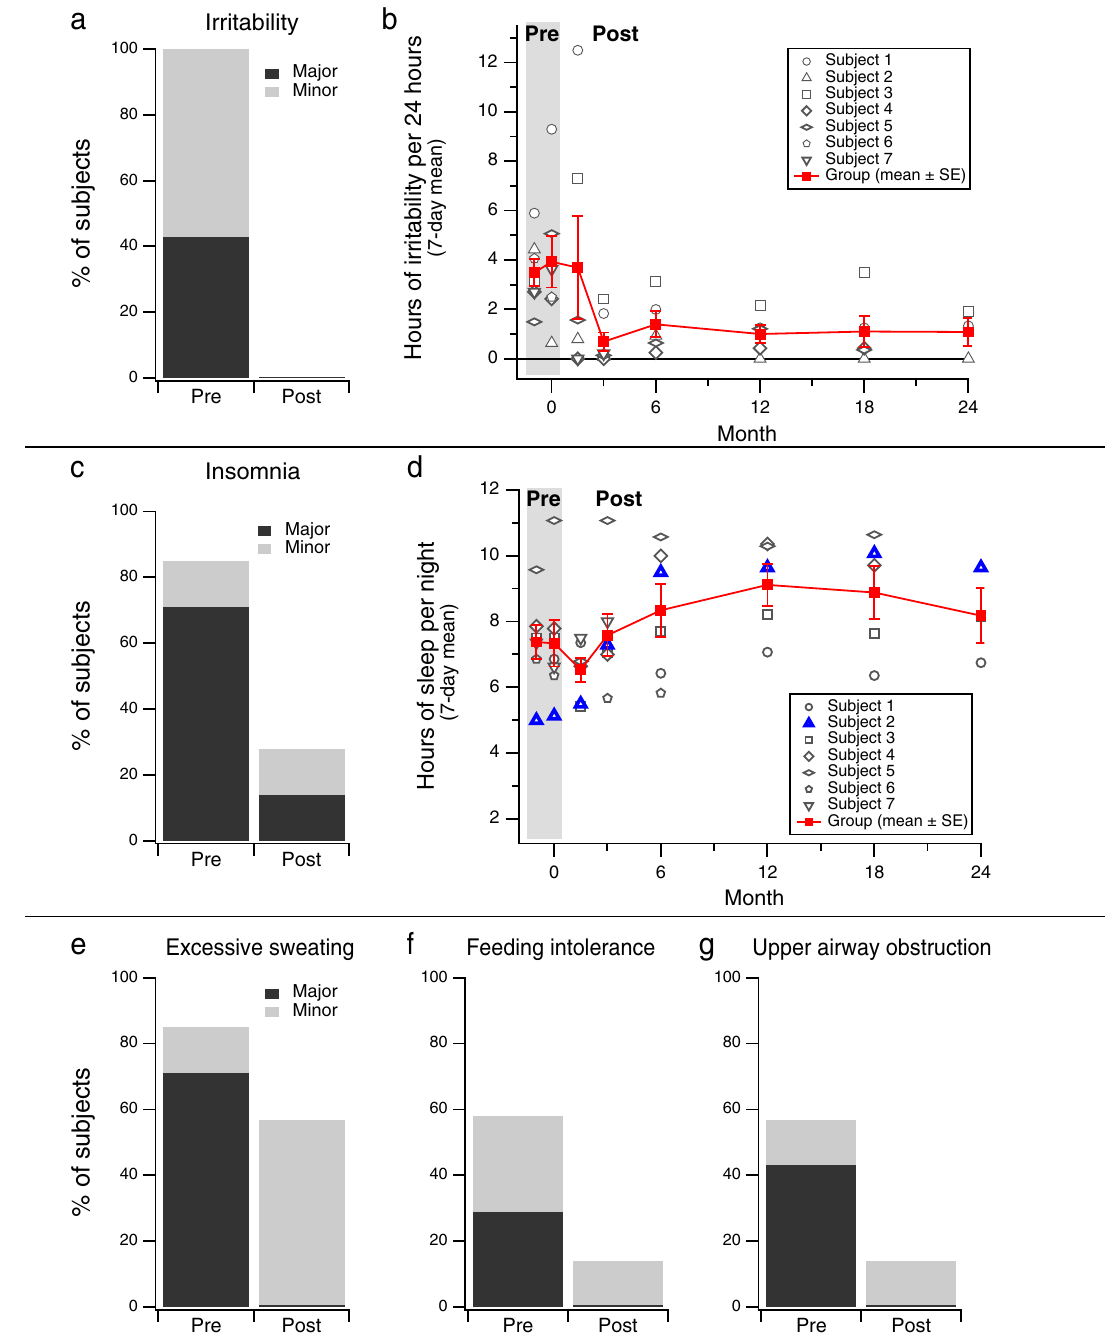
Fig. 4 Non-motor symptoms before and after gene delivery. A The percentage of subjects ( n = 7) who, by caregiver report, experienced irritability at baseline compared to the last available follow-up timepoint (Month 24 for Subjects 1 – 3, Month 18 for Subjects 4 and 5, and Month 6 for Subjects 6 and 7). B The number of hours or irritability per day recorded in caregiver diaries increased slightly immediately after surgery, and then improved on average (mean ± SE). C Prevalence and severity of insomnia before and after gene delivery by caregiver report. D The mean number of hours (±SE) of night-time sleep recorded in caregiver diaries improved slightly across subjects after gene delivery. For Subject 2 (blue triangles), the improvement was dramatic. E – G Prevalence and severity of other non-motor symptoms before and after gene delivery by caregiver report (see details in A , above). Major (black): frequent and/or severe, with signi fi cant impact on comfort or function; Minor (gray): infrequent and/or mild. Source data are provided as a Source Data fi